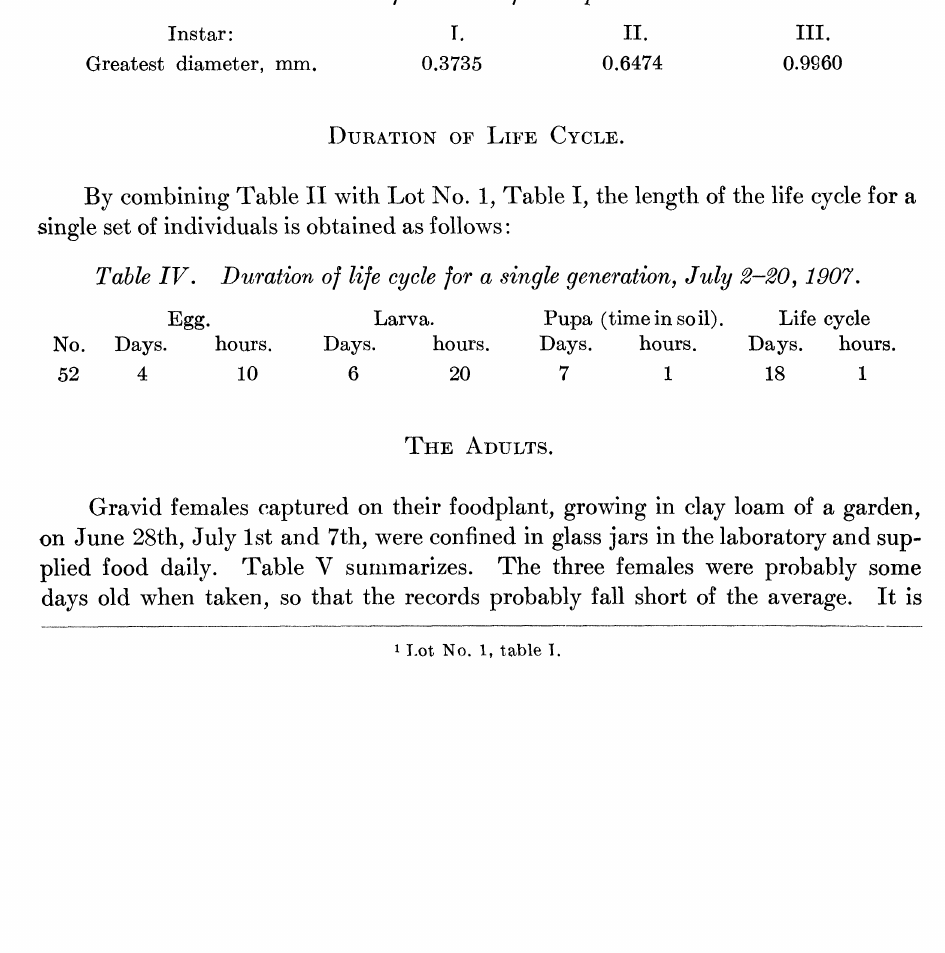
o Postembryonic Instars